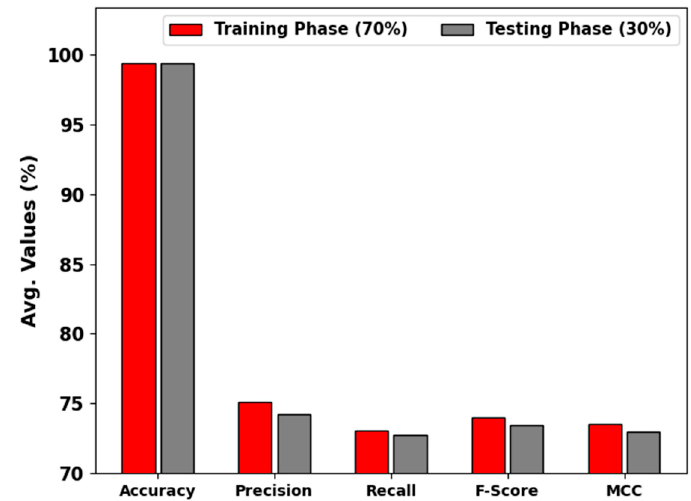
Figure 5. Average outcome of IMFL-IDSCS system under 70:30 of TR/TS databases.